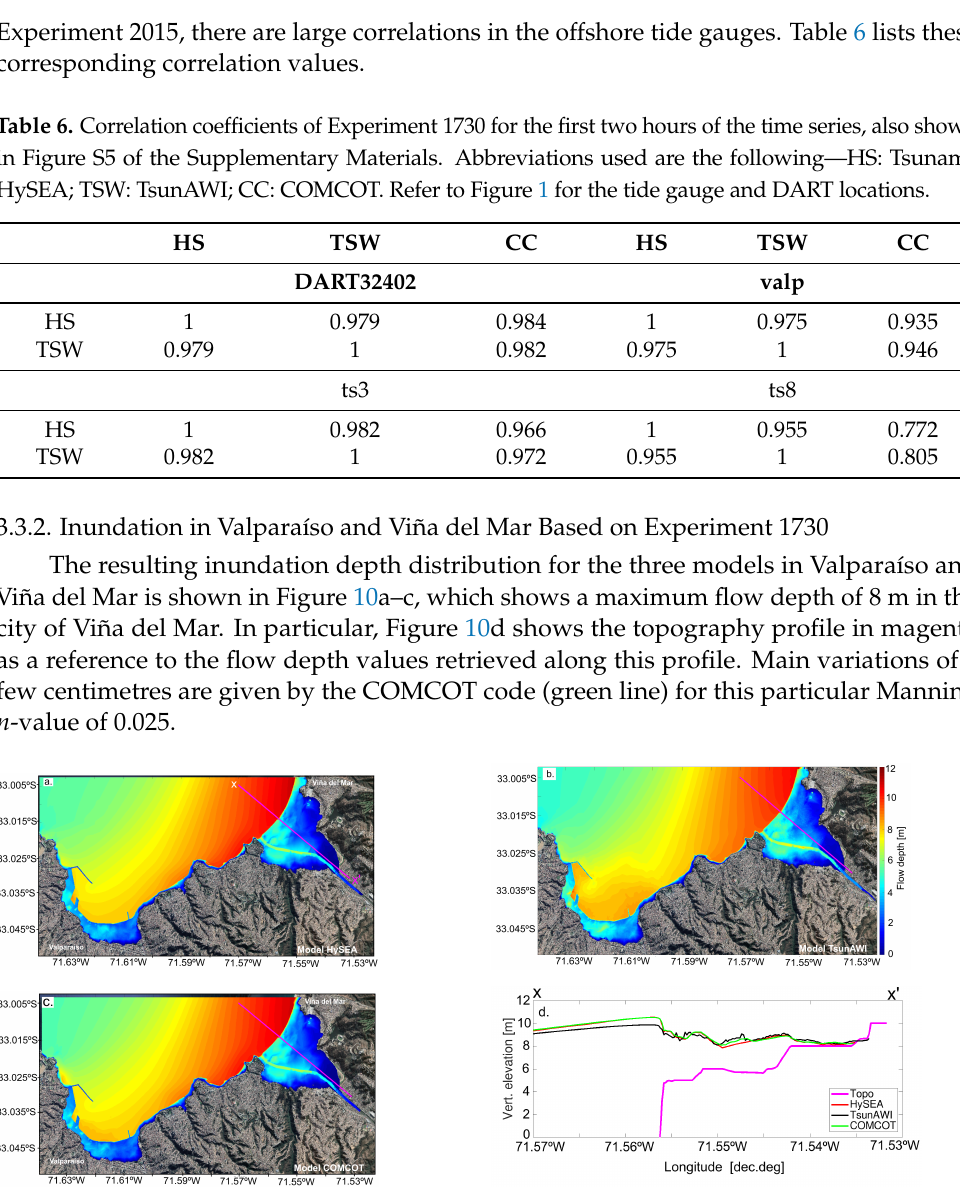
Figure 10. Maximum flow depths in Valparaíso and Viña del Mar obtained by the three numerical models for a Manning value of n = 0.025 in Experiment 1730. ( a ). Results from Tsunami-HySEA, ( b ). TsunAWI, ( c ). COMCOT. The magenta line stands for the extent of the cross section. ( d ). Lines show the maximum wave amplitude (relative to shoreline) resulting from each numerical model and the elevation above sea level (Topo). Basemap: © Google Earth